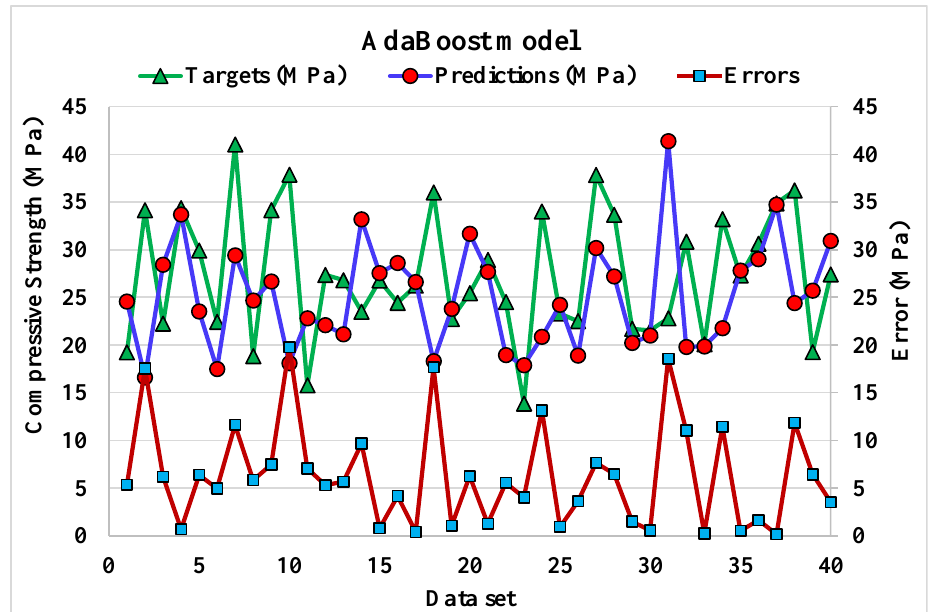
Figure 15. Dispersion of predicted and actual values along with errors for AdaBoost model.